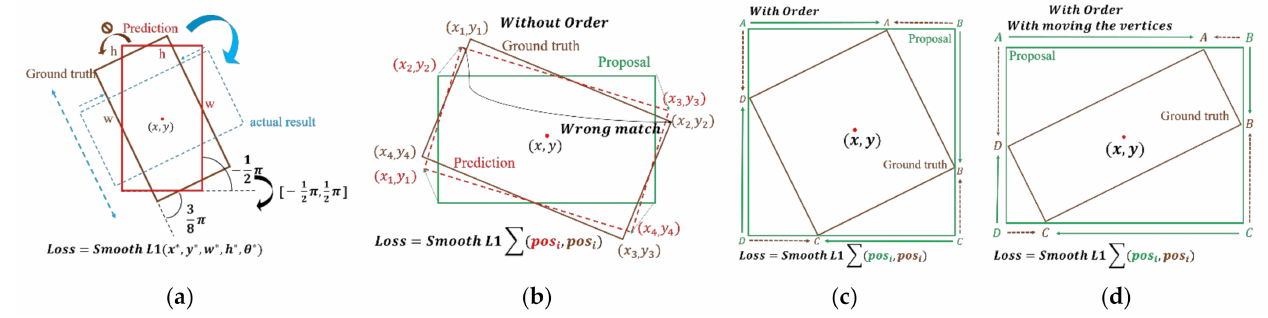
Figure 2. Boundary problems in five-parameter models ( a ) and eight-parameter models ( b – d